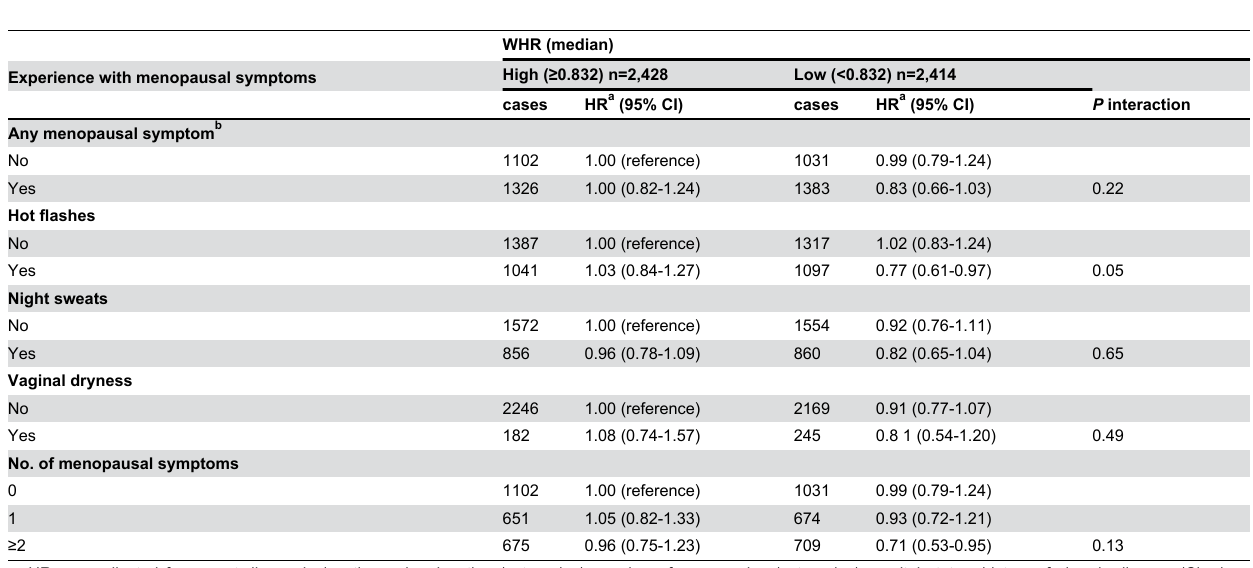
Table 4. Postdiagnosis menopausal symptoms in association with breast cancer recurrence by waist-to-hip ratio (WHR), SBCSS